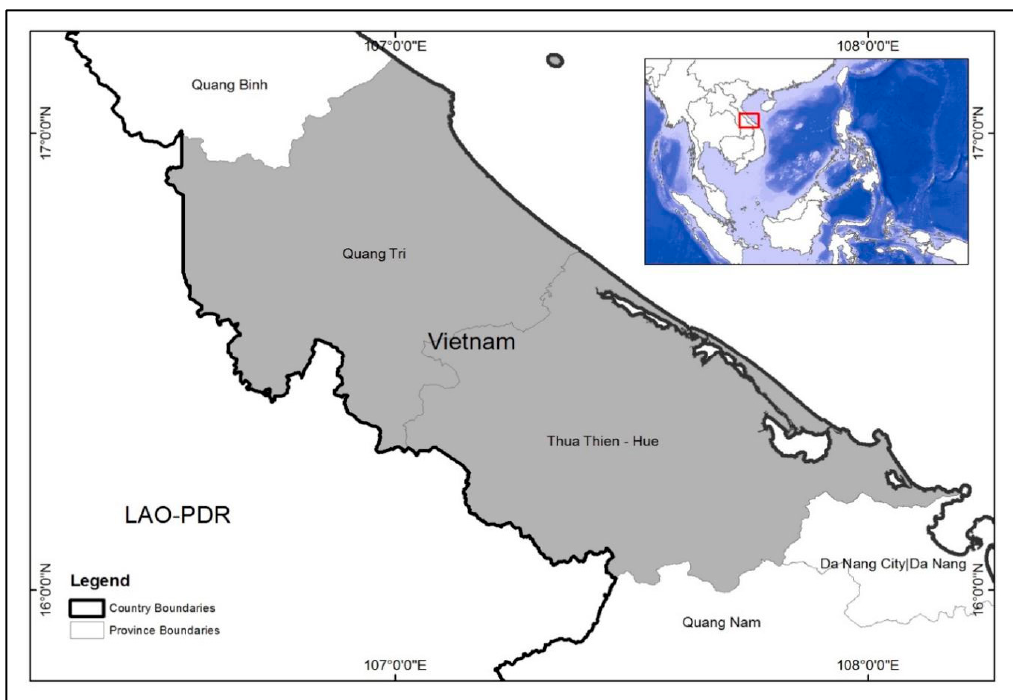
Figure 1. Map of the study area: Qu ả ng Tr ị and Th ừ a Thiên-Hu ế Provinces in Central Vietnam.